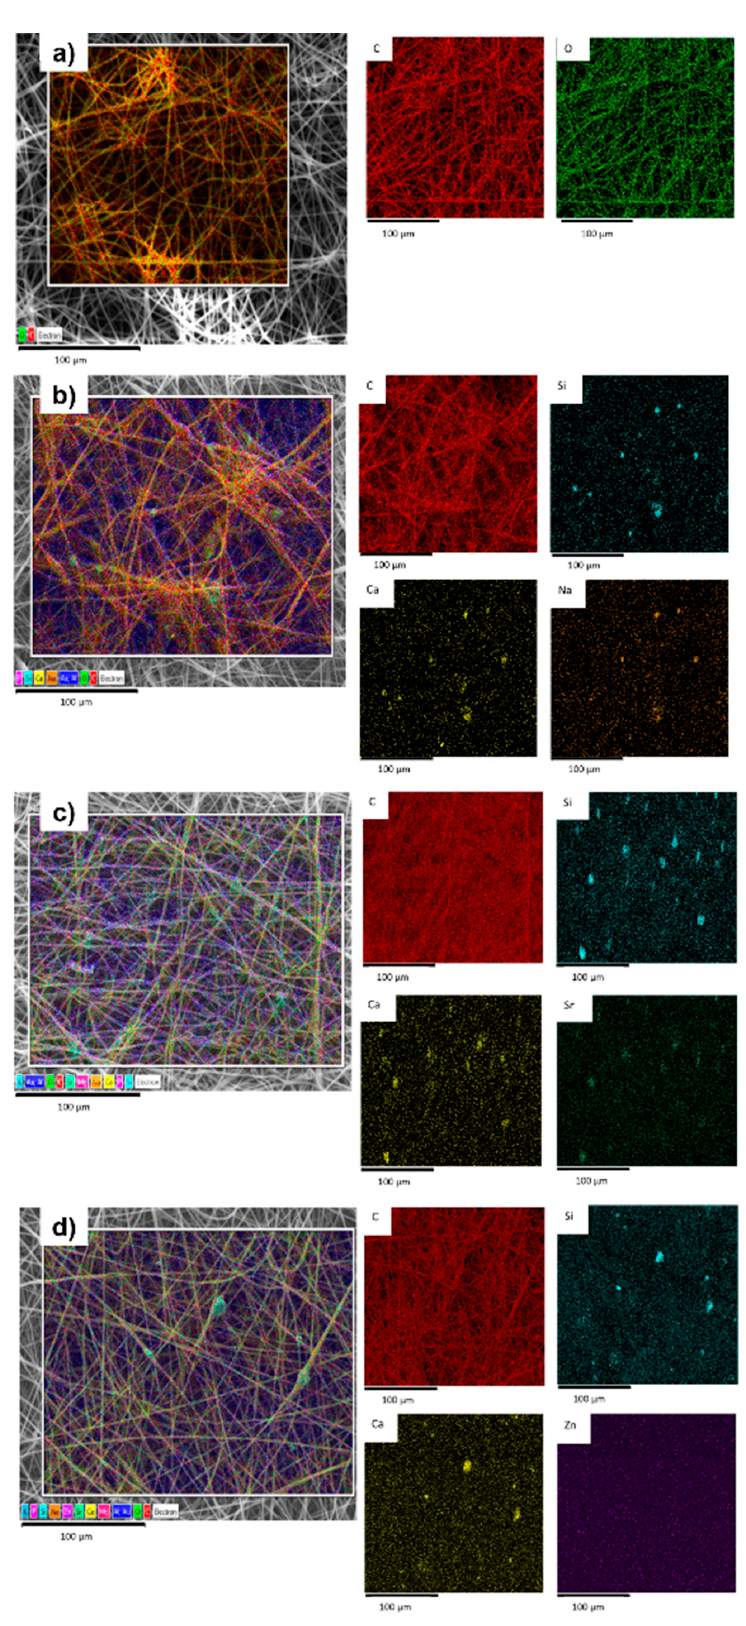
Figure 3. EDX mapping of electrospun PCL ( a ) and composites PCL_45S5 ( b ), PCL_BG10 ( c ), PCL_BGZn ( d ) at d0 (before immersion in simulated body fluid (SBF)).